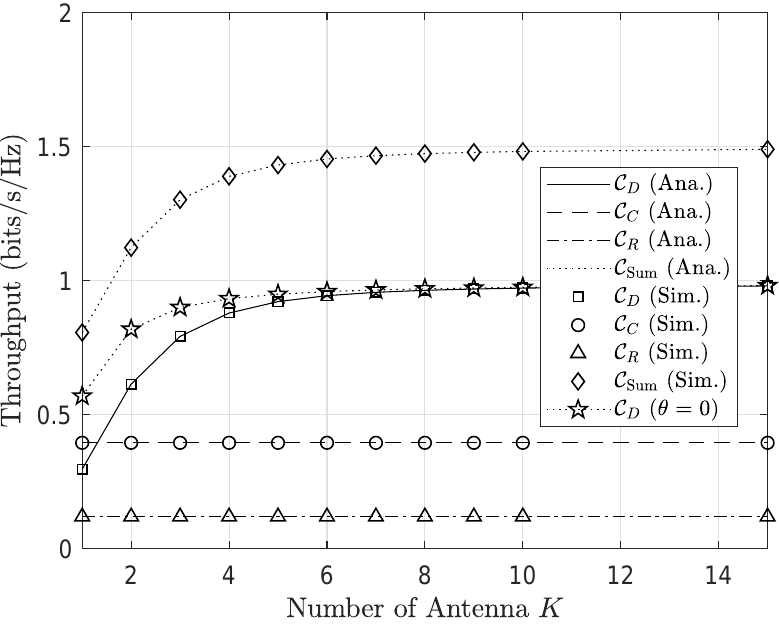
Figure 11. Throughput versus the number of antenna K .